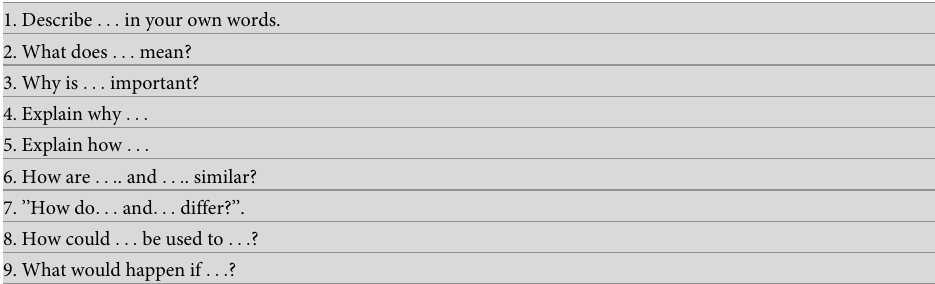
Table 3. Content-free